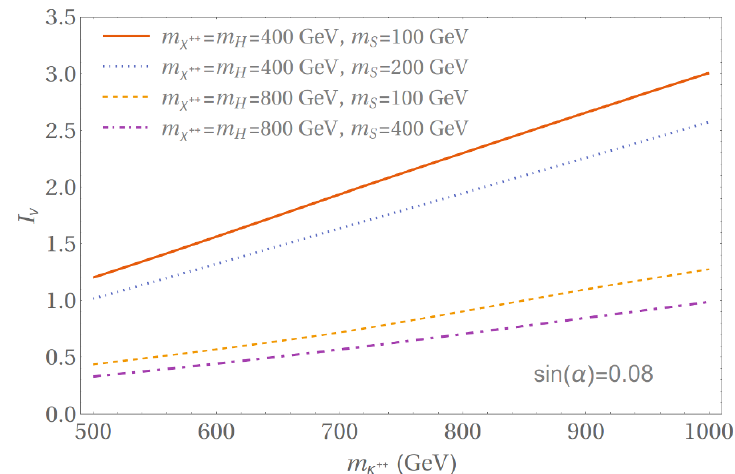
Figure 8 . The neutrino mass integral, I (cid:23) , as a function of m the other parameters. We (cid:12)x sin( (cid:11) ) = 0 : 08, use eq. (2.13b) and eq. (2.9) and take m H = m